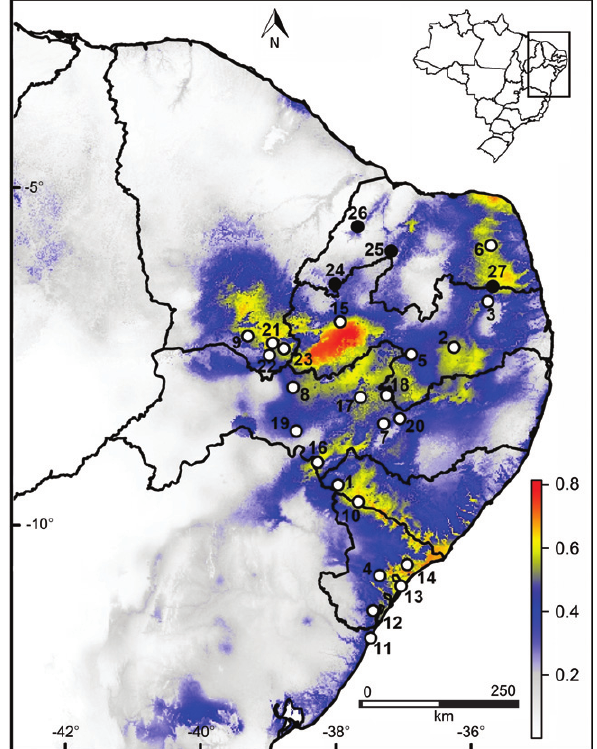
Figure 1. Known records (circles) and distribution model (colored area) of Mabuya agmosticha in northeastern Brazil. White circles represent literature records, and black circles are the new records. Colors indicate the environmental suitability predicted by the model, which ranges from 0 (white) to 1 (red). See Table I for locality names and geographic